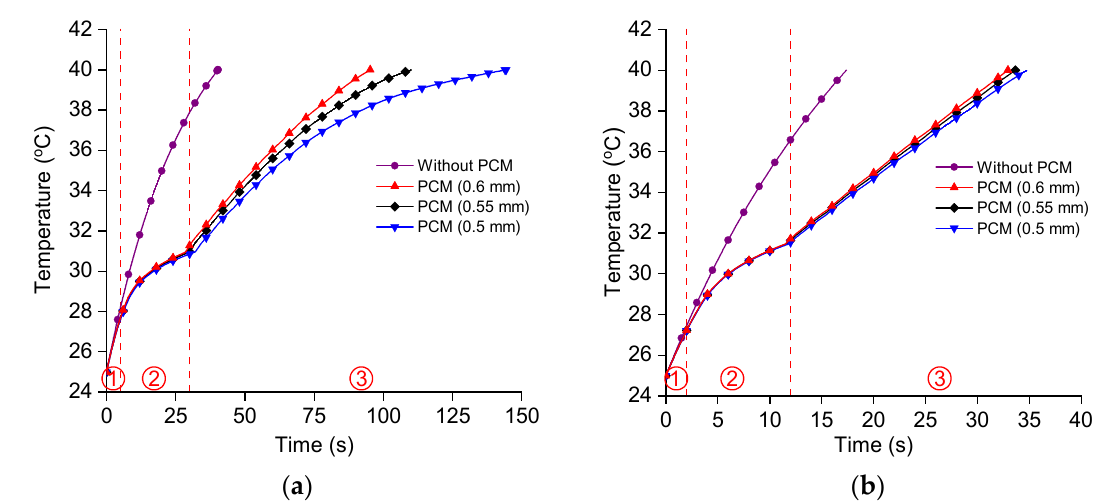
Figure 9. Rapid increases in the temperature below 40 ° C at: ( a ) the 3C discharge rate; ( b ) the 5C discharge rate (1: sensible heating of solid; 2: latent heat of fusion; 3: sensible heating of liquid).